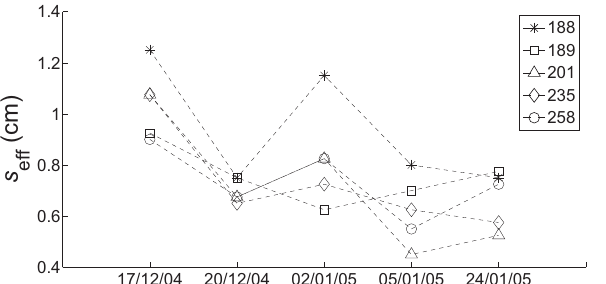
Fig. 4. Multi-temporal behaviour of the effective RMS heights ( s eff ) obtained from ENVISAT ASAR VV acquisitions over five study fields within the La Tejer´ıa (ID 6) site, Spain. Fig. 5. Dependence of s eff on the backscatter observations ( σ 0 ) for different intervals of incidence angle θ .